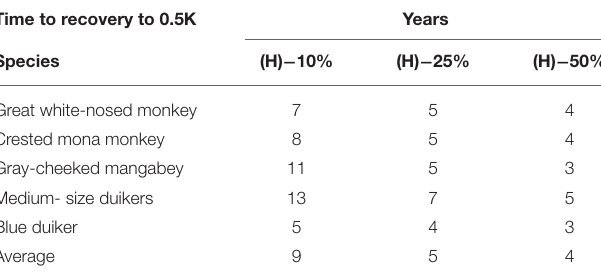
TABLE 2 | Estimated number of years that depleted wildlife populations within 6km of villages in Gabon might take to recover to 0.5K when offtake is reduced by 10, 25, or